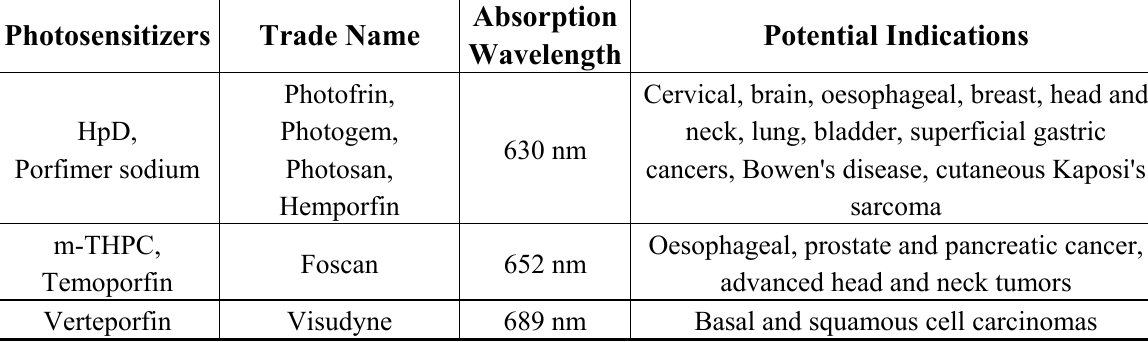
Table 1. Examples for PS used in clinical and preclinical trials in oncology [24,25,40-52].